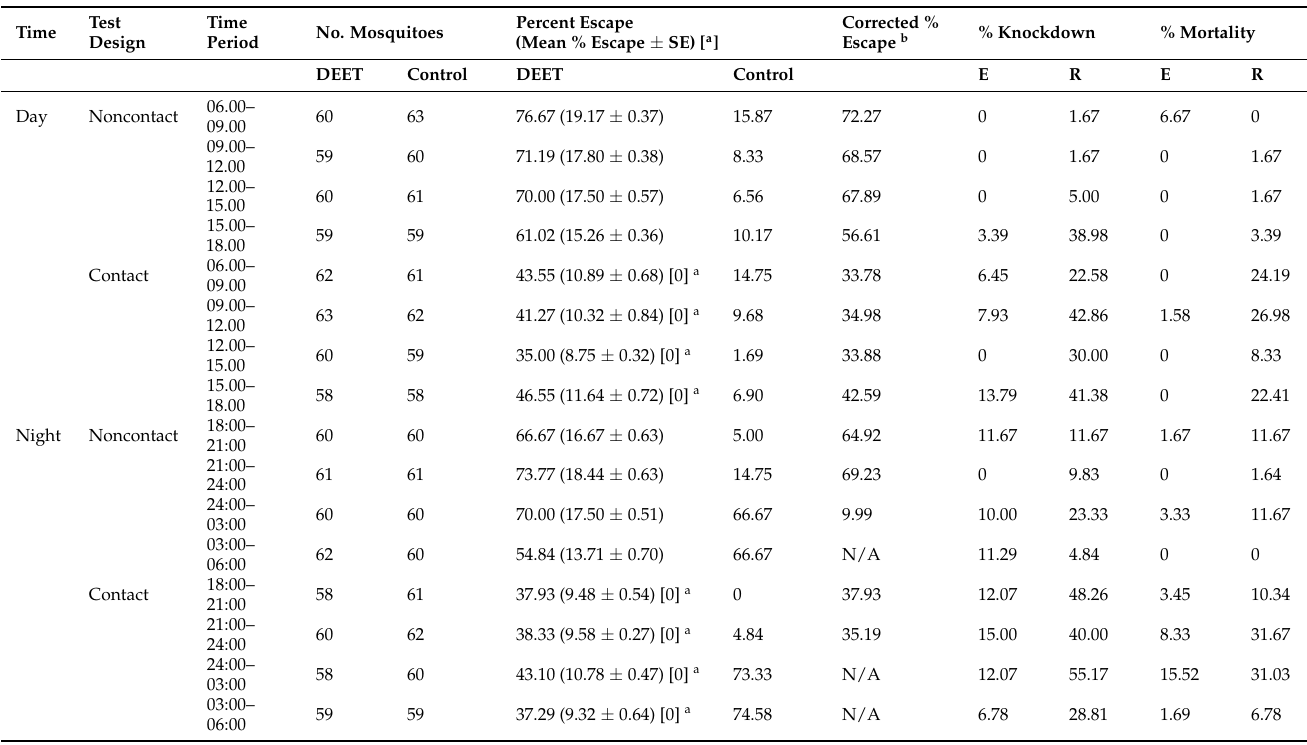
Table 3. The average percent escape, percent knockdown, and 24-h mortality of Anopheles dirus exposed to 5% DEET at different time periods of day and night using the excito-repellency assay